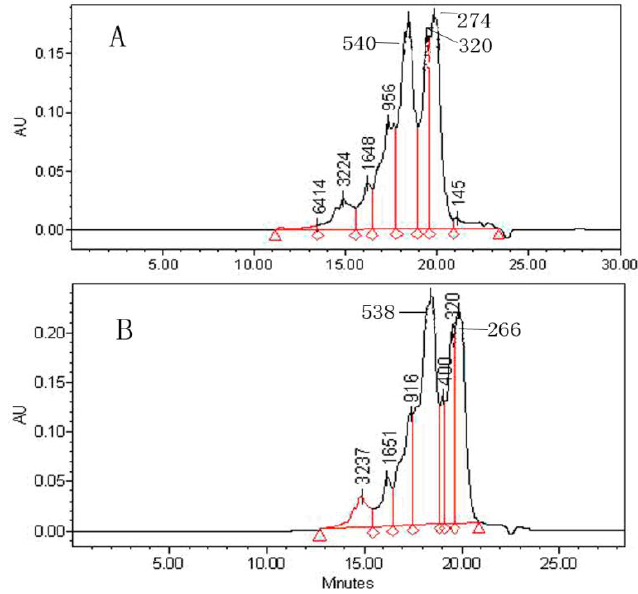
Figure 3. The molecular weight distributions of collagen hydrolysate (using neutrase) microwave assisted acid pre-treatment: ( A ) Enzyme treatment for 3 h for native collagen and ( B ) enzyme treatment for 1.5 h microwave assisted acid pre-treated